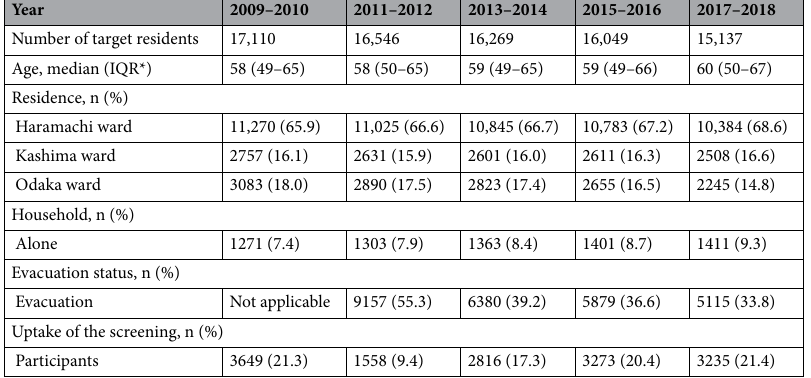
Table 2. Characteristics of the target population for each two-year period from 2009 to 2018. * IQR: interquartile range. The characteristics of the target population were defined over two-year periods. The variables are the statuses in the earlier years in each two-year period.